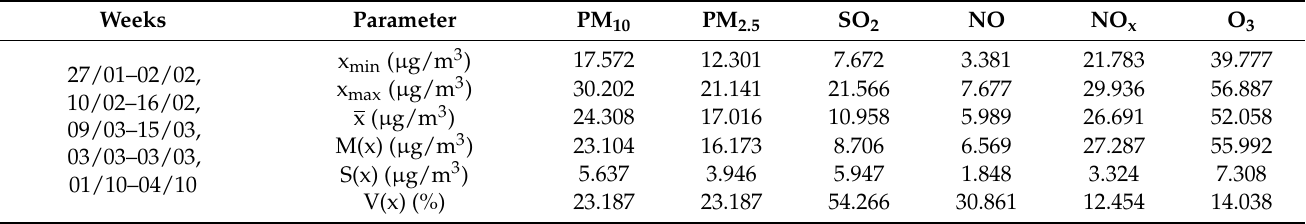
Table 7. Average measures and measures of relative variability for group no. 4.